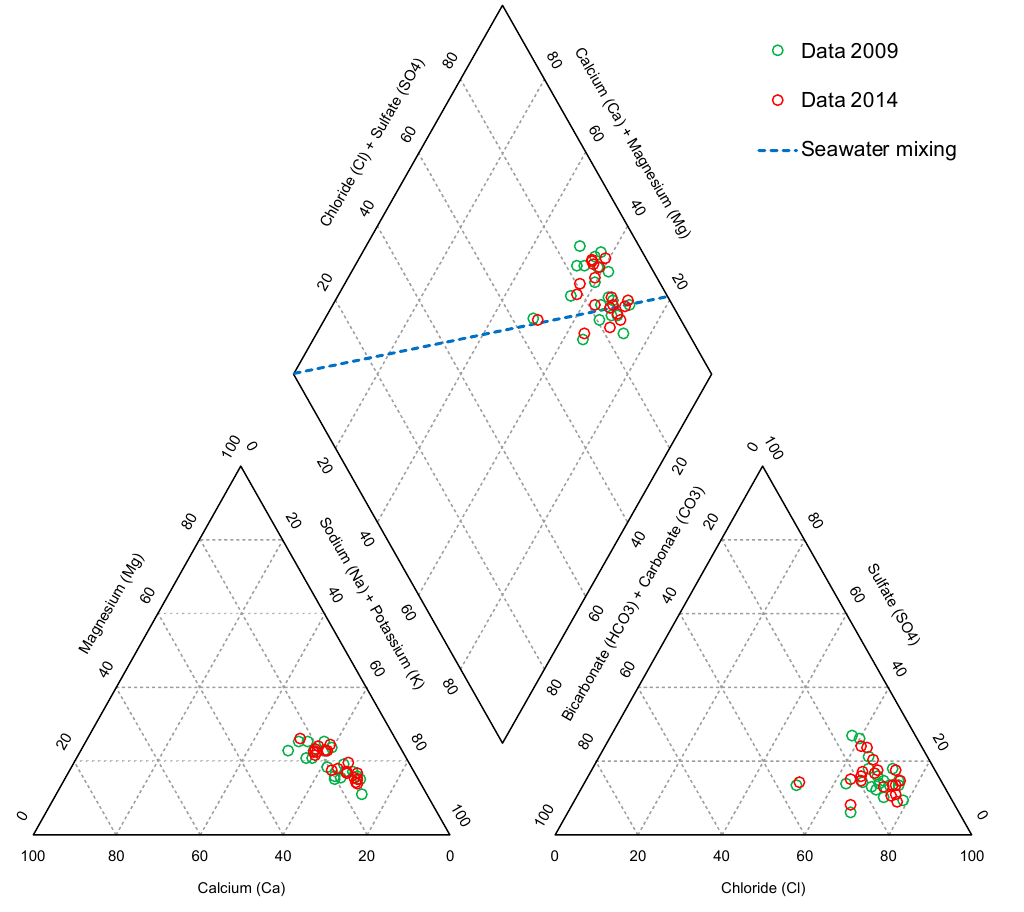
Figure 2. Piper plot showing the major ion composition of the groundwater samples and the theoretical mixing line between fresh groundwater and seawater.